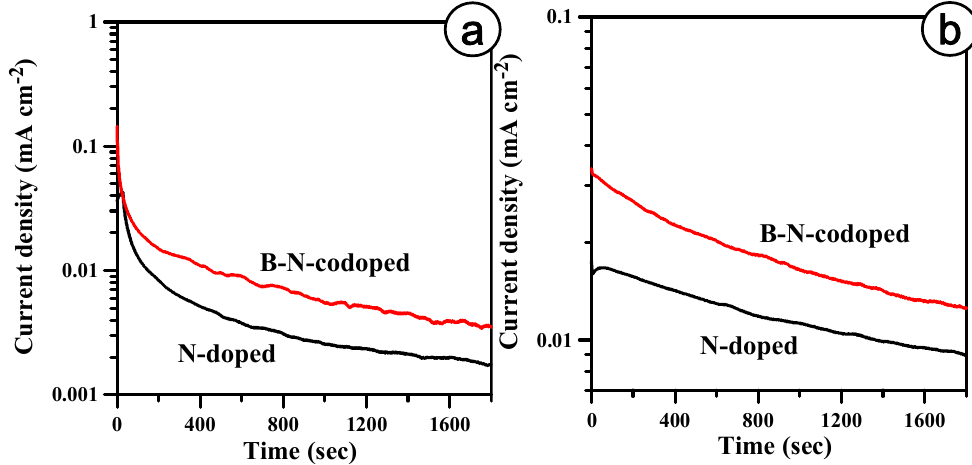
Figure 7. Current–time curves for the glucose oxidation reaction (GOR) at ( a ) 0 and ( b ) 0.2 V vs. Ag/AgCl for both catalyst electrodes.